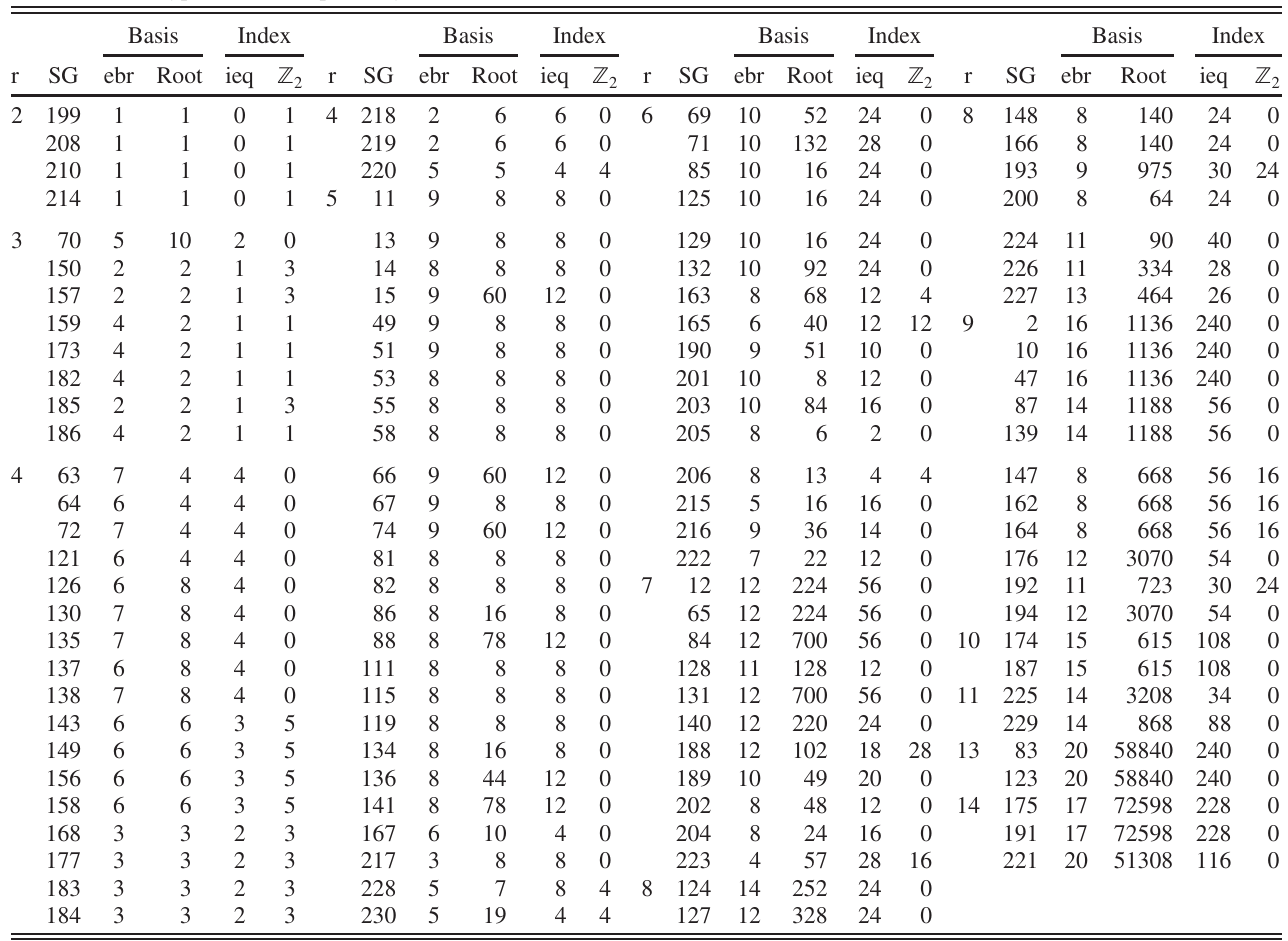
TABLE I. Sizes of Hilbert bases and numbers of fragile indices in SGs with time-reversal symmetry and significant SOC. SGs that do not have fragile indices are not tabulated. Here, “ r ” represents the rank of the EBR matrix. The terms “ ebr ” and “ root ” represent the ¯ Y numbers of EBRs and fragile roots in the Hilbert bases of , respectively, and, “ ieq ” and “ Z 2 ” represent the numbers of inequality-type indices and Z 2 -type indices,